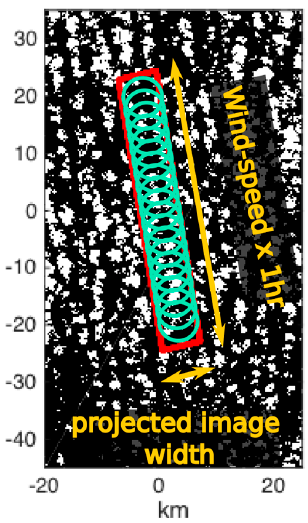
Figure A3. Cartoon of generation of TSI-like images sampling the cloud mask from Landsat image captured on 15 May 2006, 16:59 UTC. Red box indicates the Landsat subarea observed by the TSI over a 1-h analysis period with a 130° FOV with SGP site at the origin. Green circles indicate 30-s simulated TSI-like observations as the frozen cloud field moves overhead, actual simulation uses 120 green circles. The TSI-like clouds are truncated at the 130°-FOV circle, whereas the Landsat cloud sizes are not truncated.